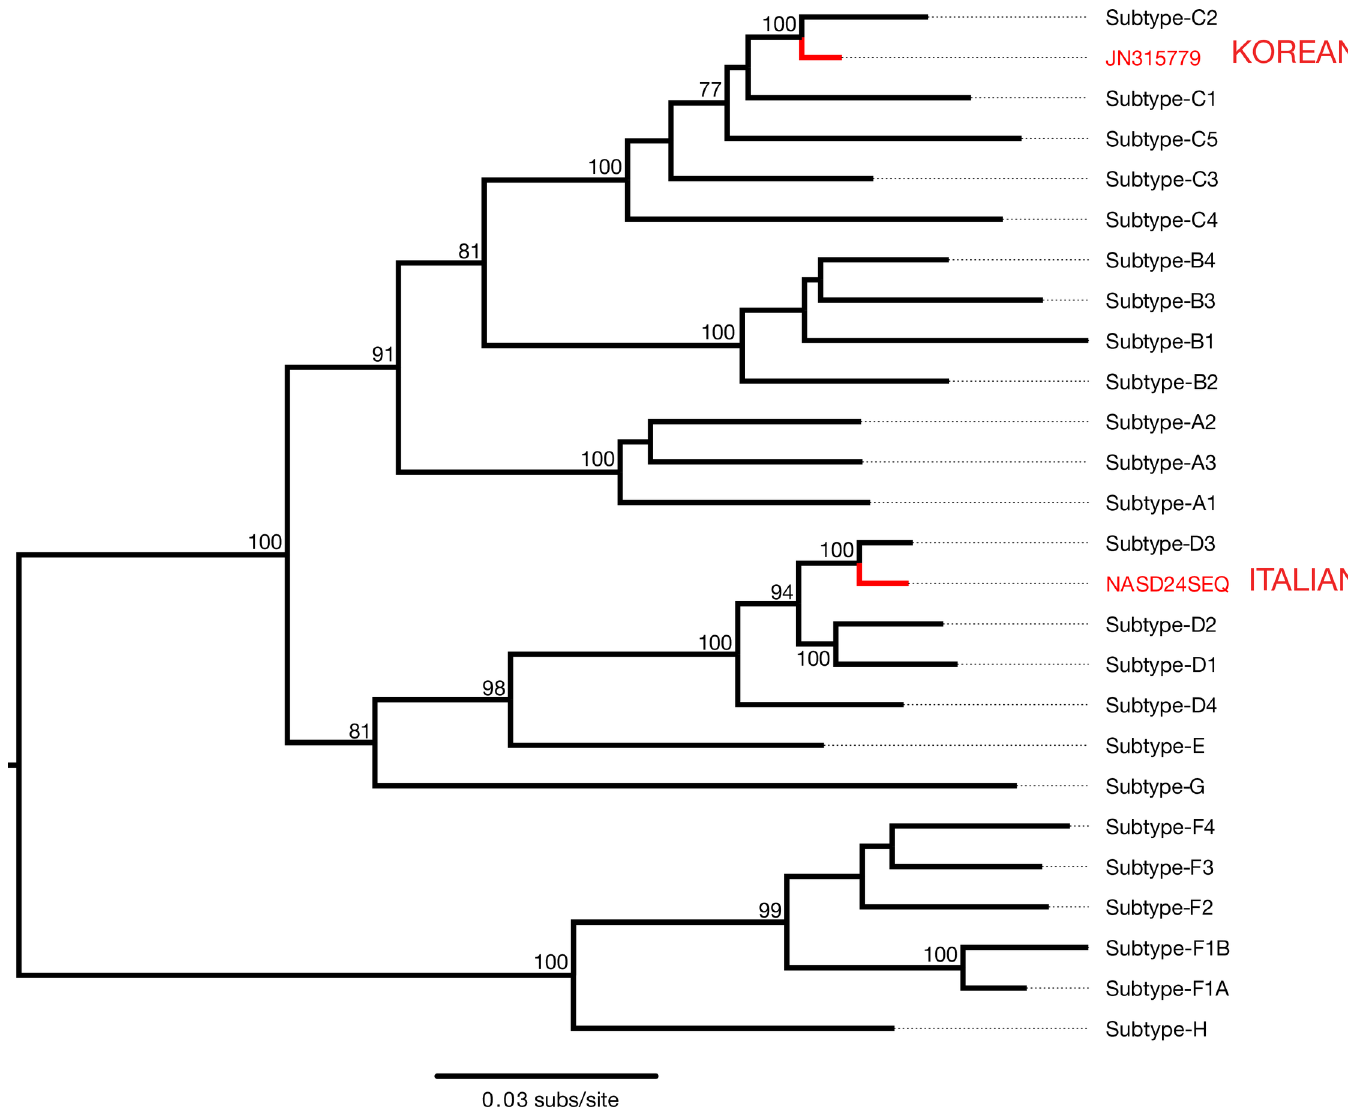
Fig 2. Phylogenetic analysis revealsthat the HBV sequence reads from NASD24are from a subgenotype D3 virus. Maximum likelihoodphylogeny of HBV sequencesrepresentative of the full genotypicdiversity. Tip labelsindicate viral genotype. The draft genome from HBV reads from NASD24 (Italian Mummy) and the JN315779sequence(KoreanMummy) are coloredin red. Nodes with bootstrapsupport above70% are displayed. All horizontalbranch lengthsare scaled accordingto the numberof nucleotidesubstitutions per site and the tree is mid-pointrooted for clarity only.